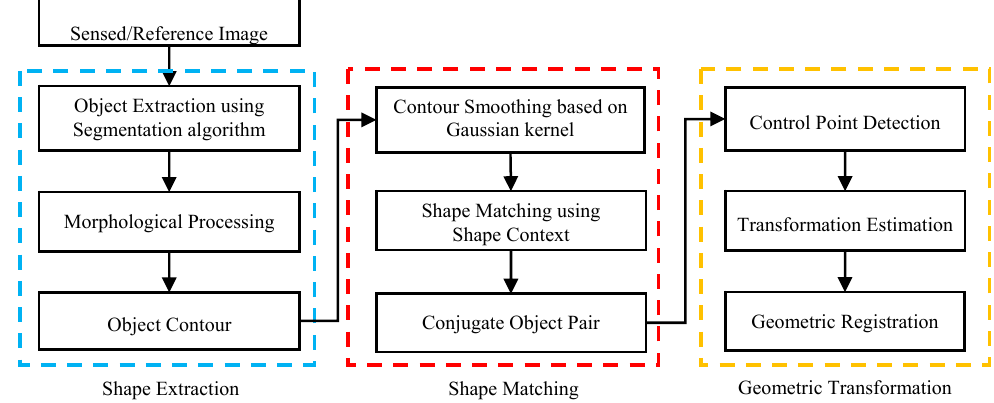
Figure 1. Image registration flowchart.